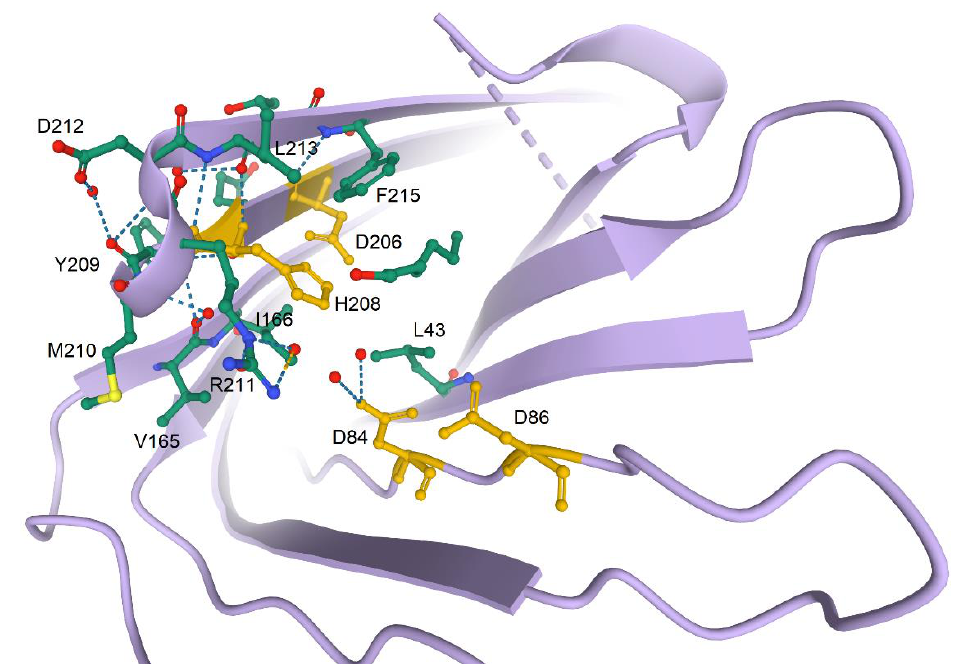
Figure 5. Zoomed in structure of the active site of Pla from Y. pestis illustrating some peculiarities of the local environment of four catalytic residues of this protein, Asp 84 , Asp 86 , Asp 206 , and His 208 . X-ray crystal structure of Pla from Y. pestis was used here (PDB ID 2X55) [30].